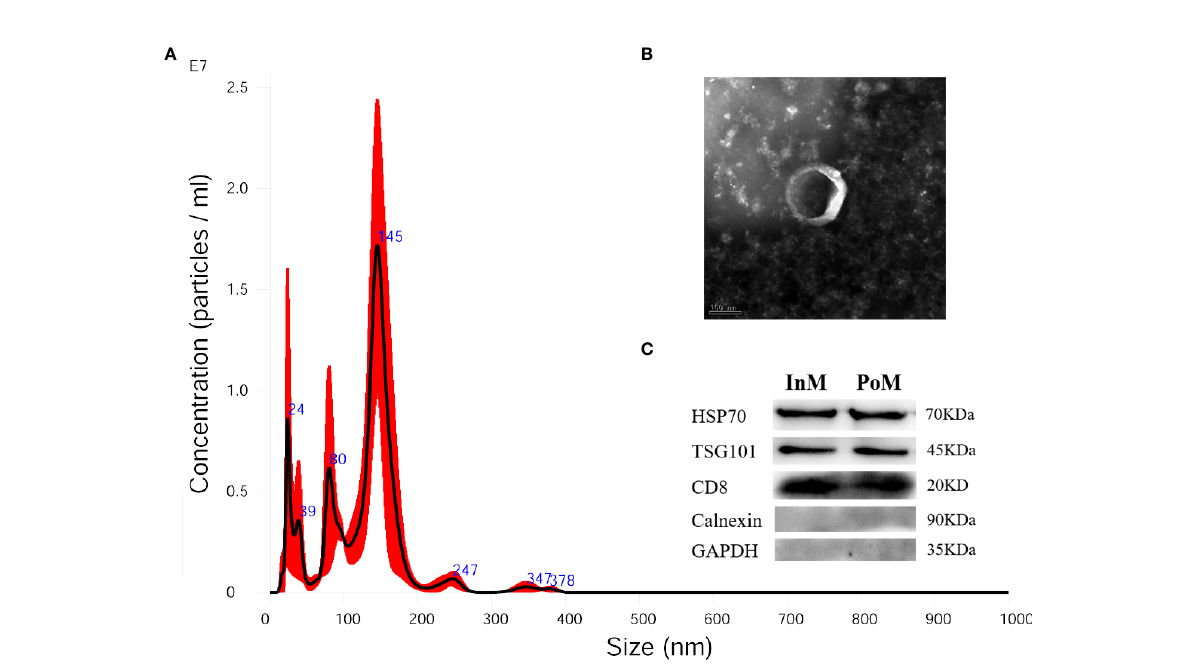
FIGURE 5 Isolated EVs from hemolymph of S. paramamosain . (A) Nanoparticle tracking analysis (NTA) showing a representative size distribution pro fi le of mud crab EVs. (B) Transmission electron microscopy (TEM) from mud crab EVs; scale bar represents 100 nm. (C) Western blotting analysis (WB) showing mud crab EVs positive for CD81, HSP70 and TSG101; Calnexin and GAPDH served as negative control; the molecular weight for standard is indicated in kilodaltons